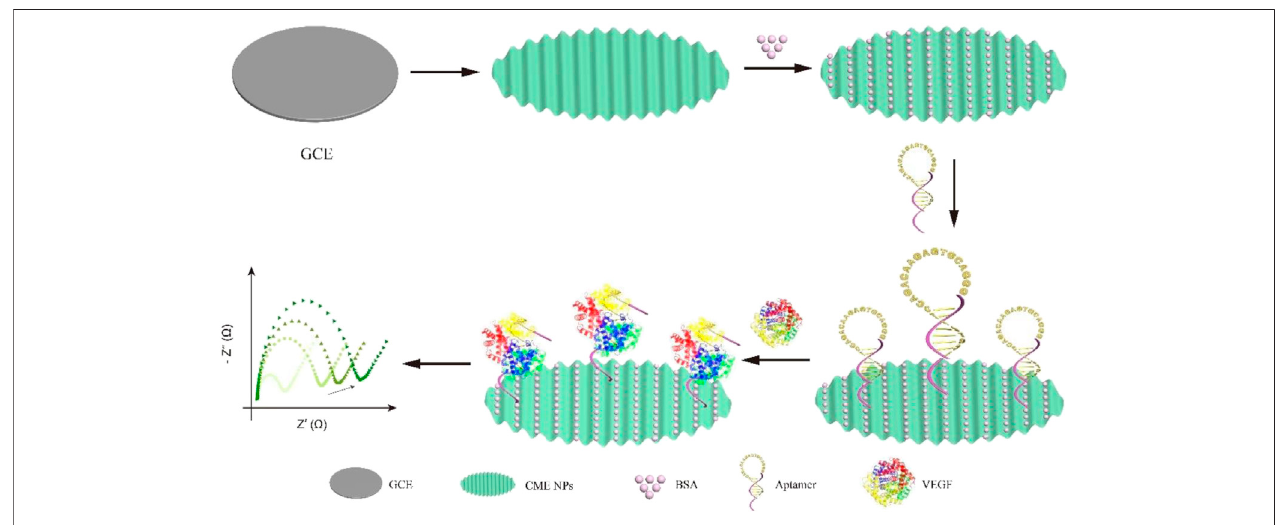
SCHEME 1 | Schematic illustration of VEGF aptasensor based on CME